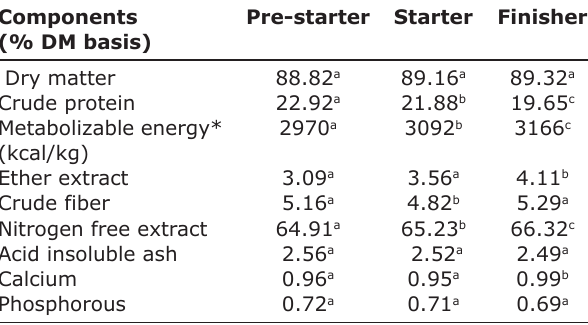
Table-1: Ingredients (%) of broiler starter and finisher